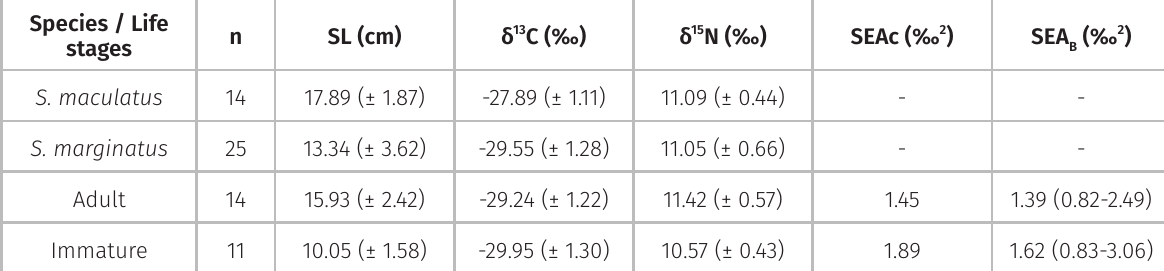
Table I. Mean (±Standard Deviation) of standard length (SL) and of δ 13 C and δ 15 N values of each fish species. All Serrasalmus maculatus were adult individuals. Adult and immature represent the size-class categories of the non-native piranha Serrasalmus marginatus and its respective isotopes and size. For each species, and life stage (where possible) is the number of sampled individuals (n), the standard length (SL), corrected standard ellipse area (SEAc) and the mode of model-estimated standard ellipse area (SEA